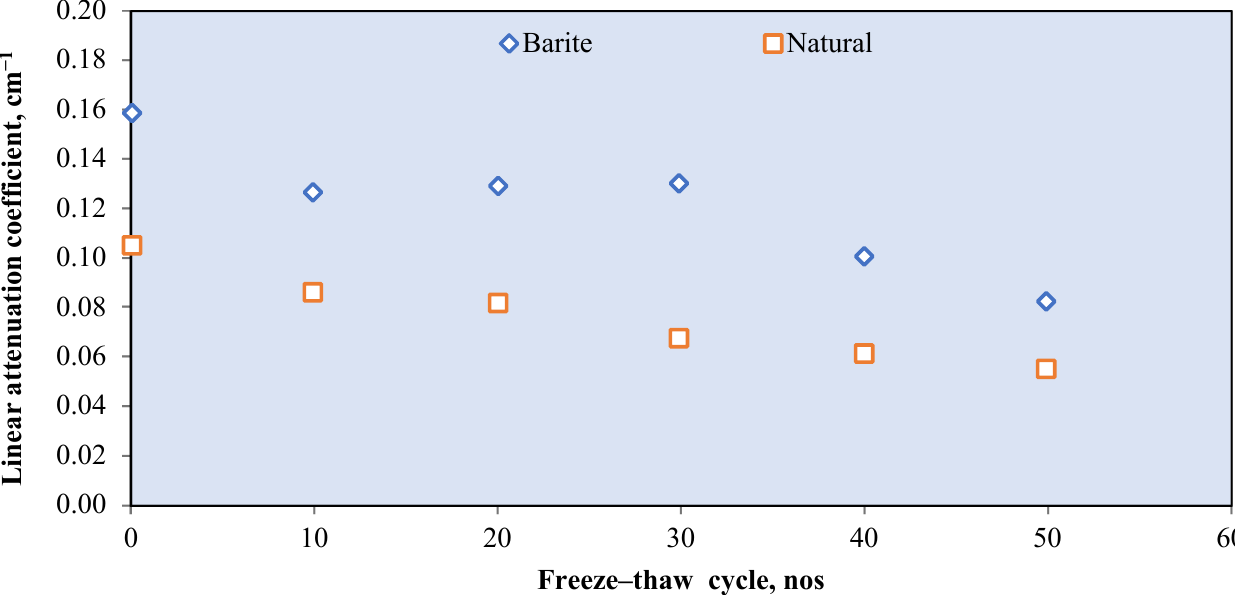
Figure 18. Value of linear attenuation coefficient based on exposure to freeze–thaw cycles (adapted with improvements from [195]).